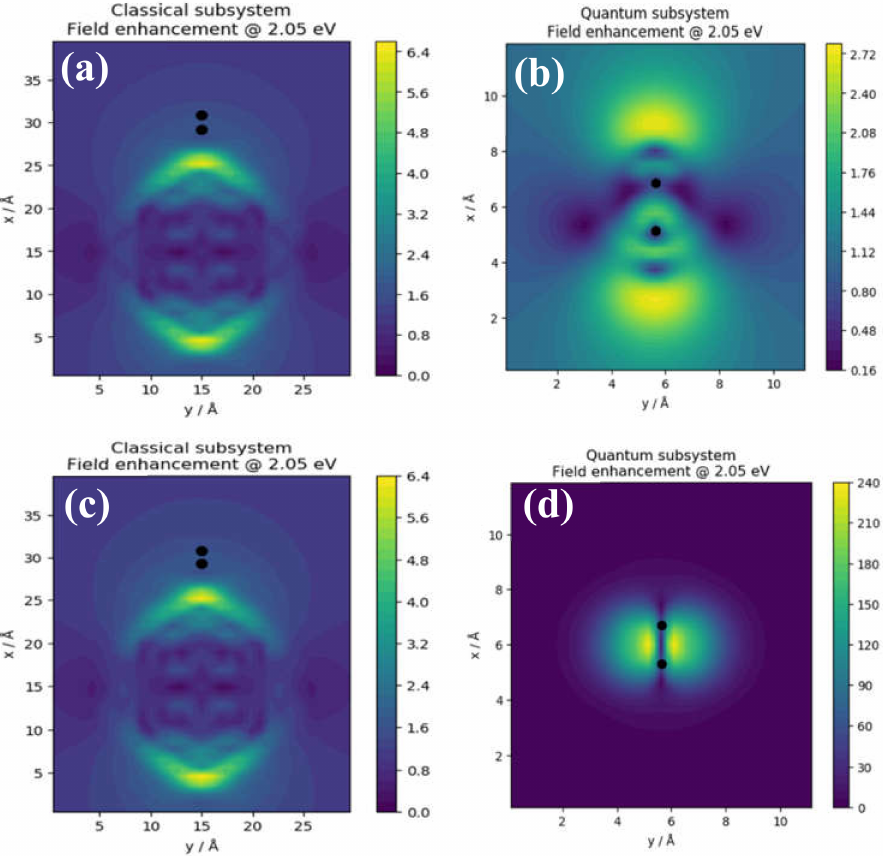
Figure 4. Local distribution of field enhancement in the Classical ( a , c ) and Quantum ( b , d ) subsystems for TaAs (top panels) and graphene (bottom panels). The color bars denote the field enhancement in